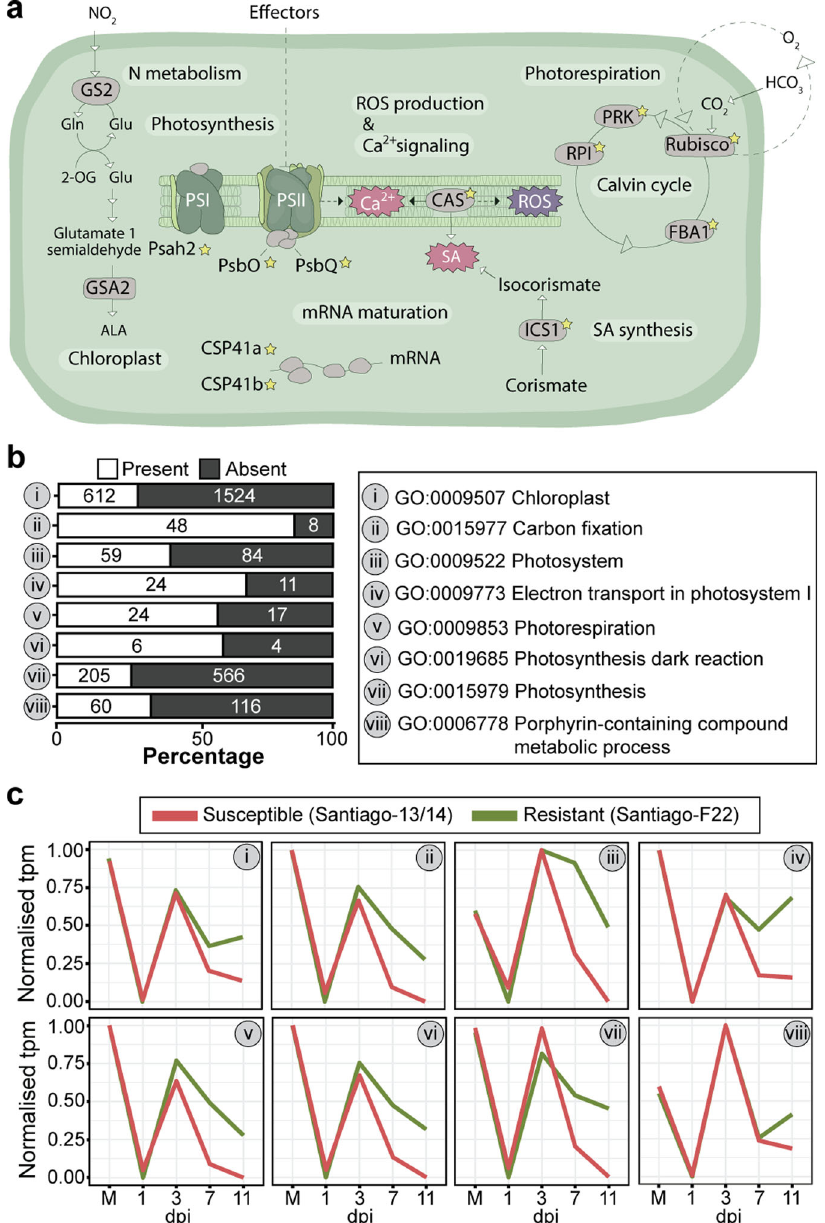
Fig. 5 Nuclear genes encoding chloroplast-localised proteins (NGCPs) are differentially expressed early during Pst infection and have temporarily coordinated expression pro fi les. a Schematic illustration of the chloroplast. The genes encoding the proteins marked with a star were identi fi ed as differentially expressed at 1 dpi across wheat varieties upon infection with Pst isolate 13/14. b Many genes are annotated with chloroplast-related functions among the 8627 Pst 13/14-speci fi c DEGs, as 1038 DEGs belong to eight second-level GO terms with chloroplast-related functions. c Chloroplast-related DEGs show a conserved, temporally regulated expression pro fi le during Pst infection. Normalised transcripts per million (tpm) values were used to determine the median expression levels for genes assigned to each of the eight chloroplast-related GO